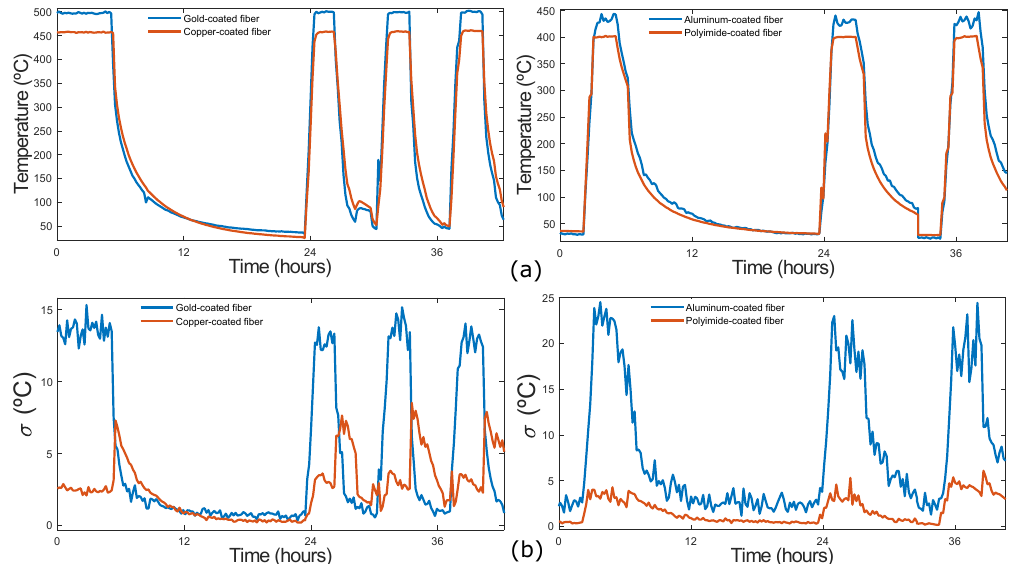
Figure 7. ( a ) The average temperature of the hot-spot section for the four fibers; ( b ) variance ( σ ) of the hot-spot section for the four